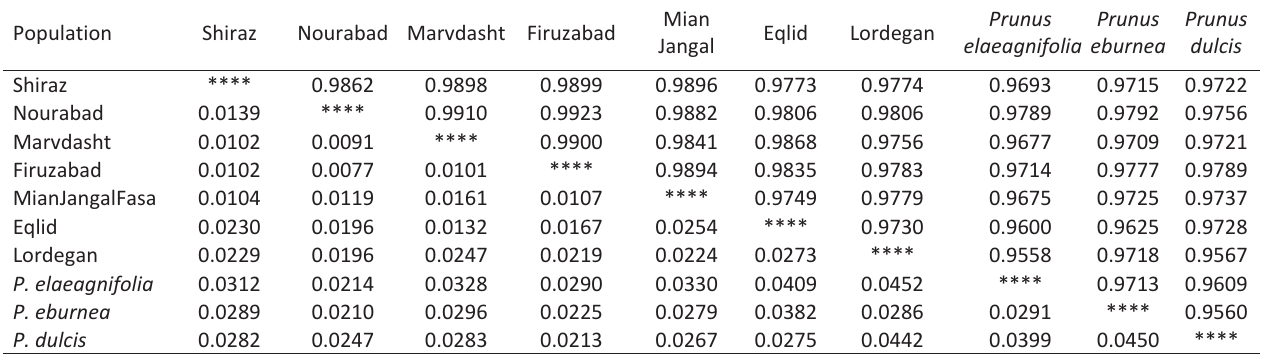
Table 5 ­ Genetic identity (above diagonal) and genetic distance (below diagonal) estimates between populations across all loci based on Nei (1978)